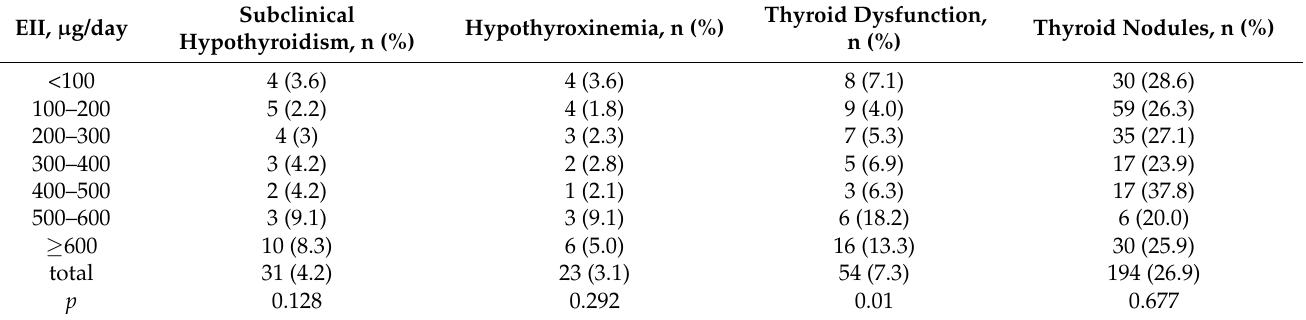
Table 4. Thyroid dysfunction and thyroid nodules in pregnant women in terms of EII (N = 744).